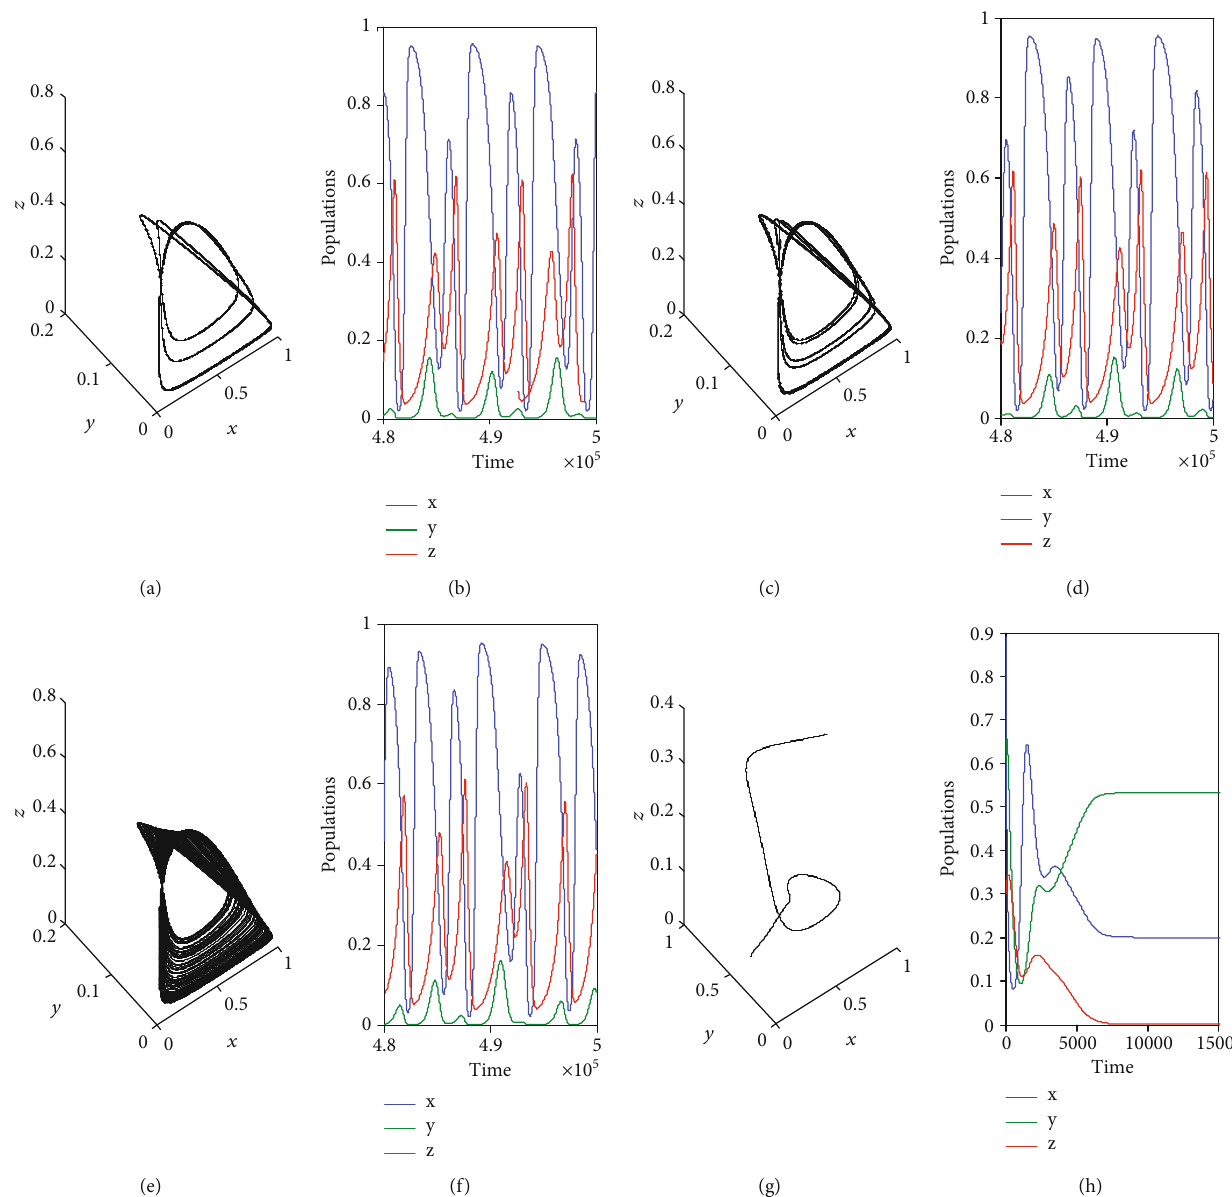
= 0 : 45 . (b) Time series of attractor in + where c